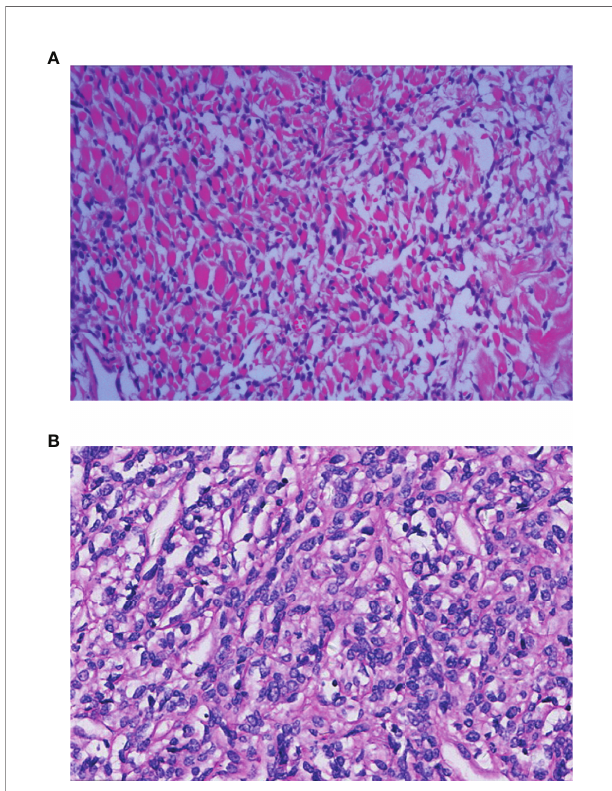
FIGURE 2 | Histopathological features of the benign and malignant SFTP patients: (A) The benign cells are spindle-shaped or short spindle-shaped and grow randomly without structure [Hematoxylin Eosin(HE) staining×10]; and (B) the malignant cells are abundant and dense, and obvious atypia and mitoses can be seen (HE×10).